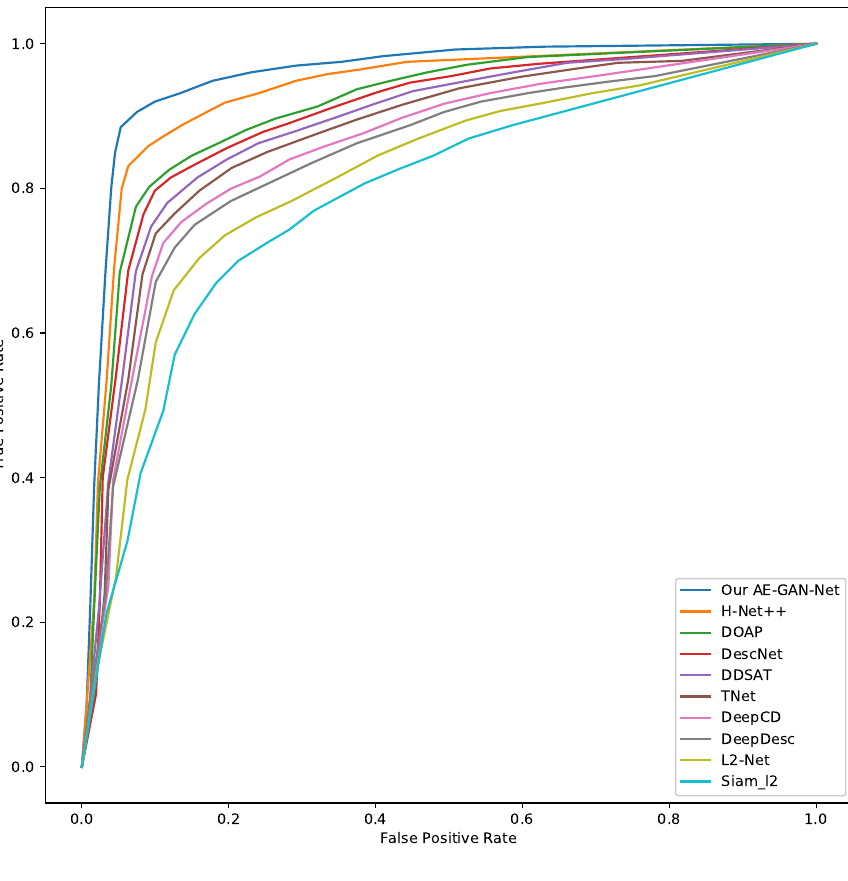
Figure 9. ROC curve based on testing data for our AE-GAN-Net and competing